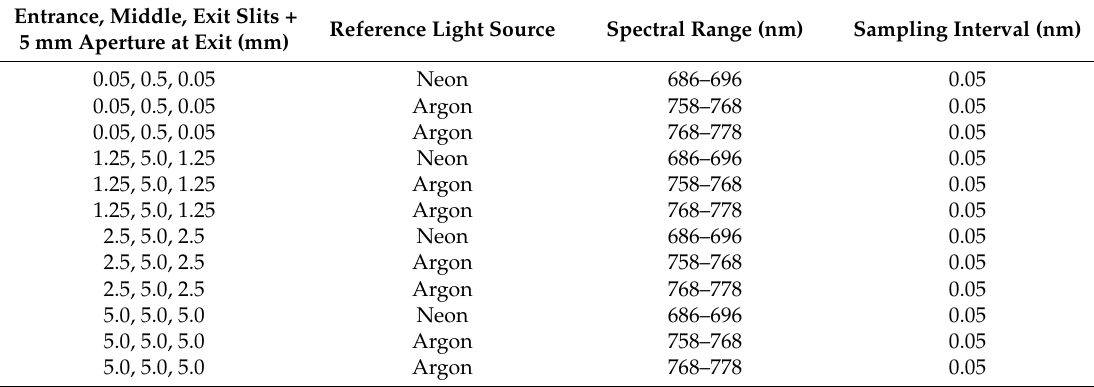
Table 1. Configurations selected for OL750D characterization.